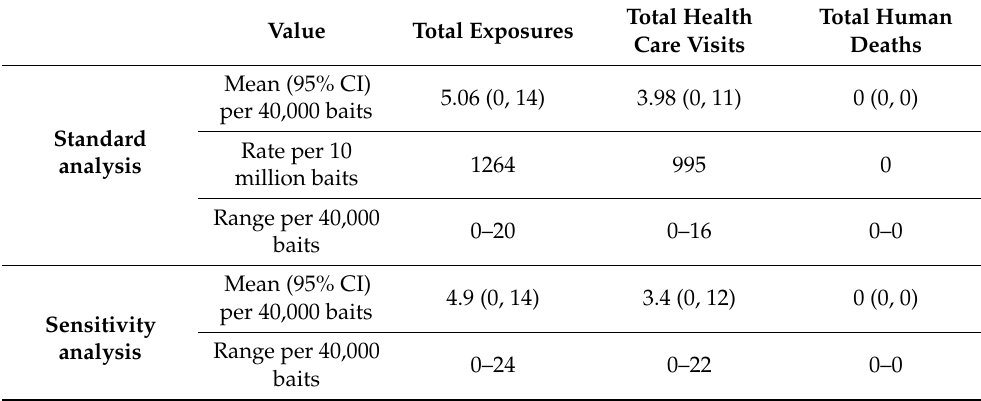
Table 3. Table of estimated exposures, health care visits and deaths from simulation of a 40,000 bait ORV campaign using estimated parameters for Goa, India. Standard analysis used parameters estimated from available data. Sensitivity analysis used Latin Hypercube parameter selection from the range of possible